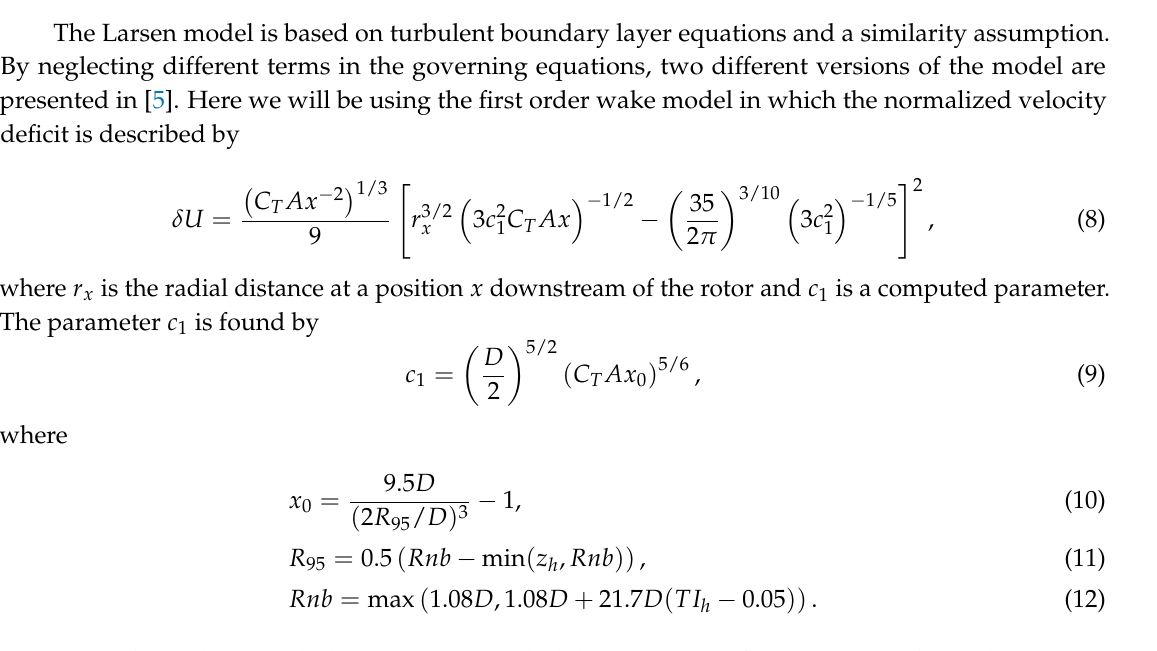
Figure 2. Schematic representation of the Jensen wake model. ( D is the rotor diameter, U ∞ the undisturbed wind velocity, x the downstream distance of the wake from the rotor, V the velocity within the wake and k the wake expansion